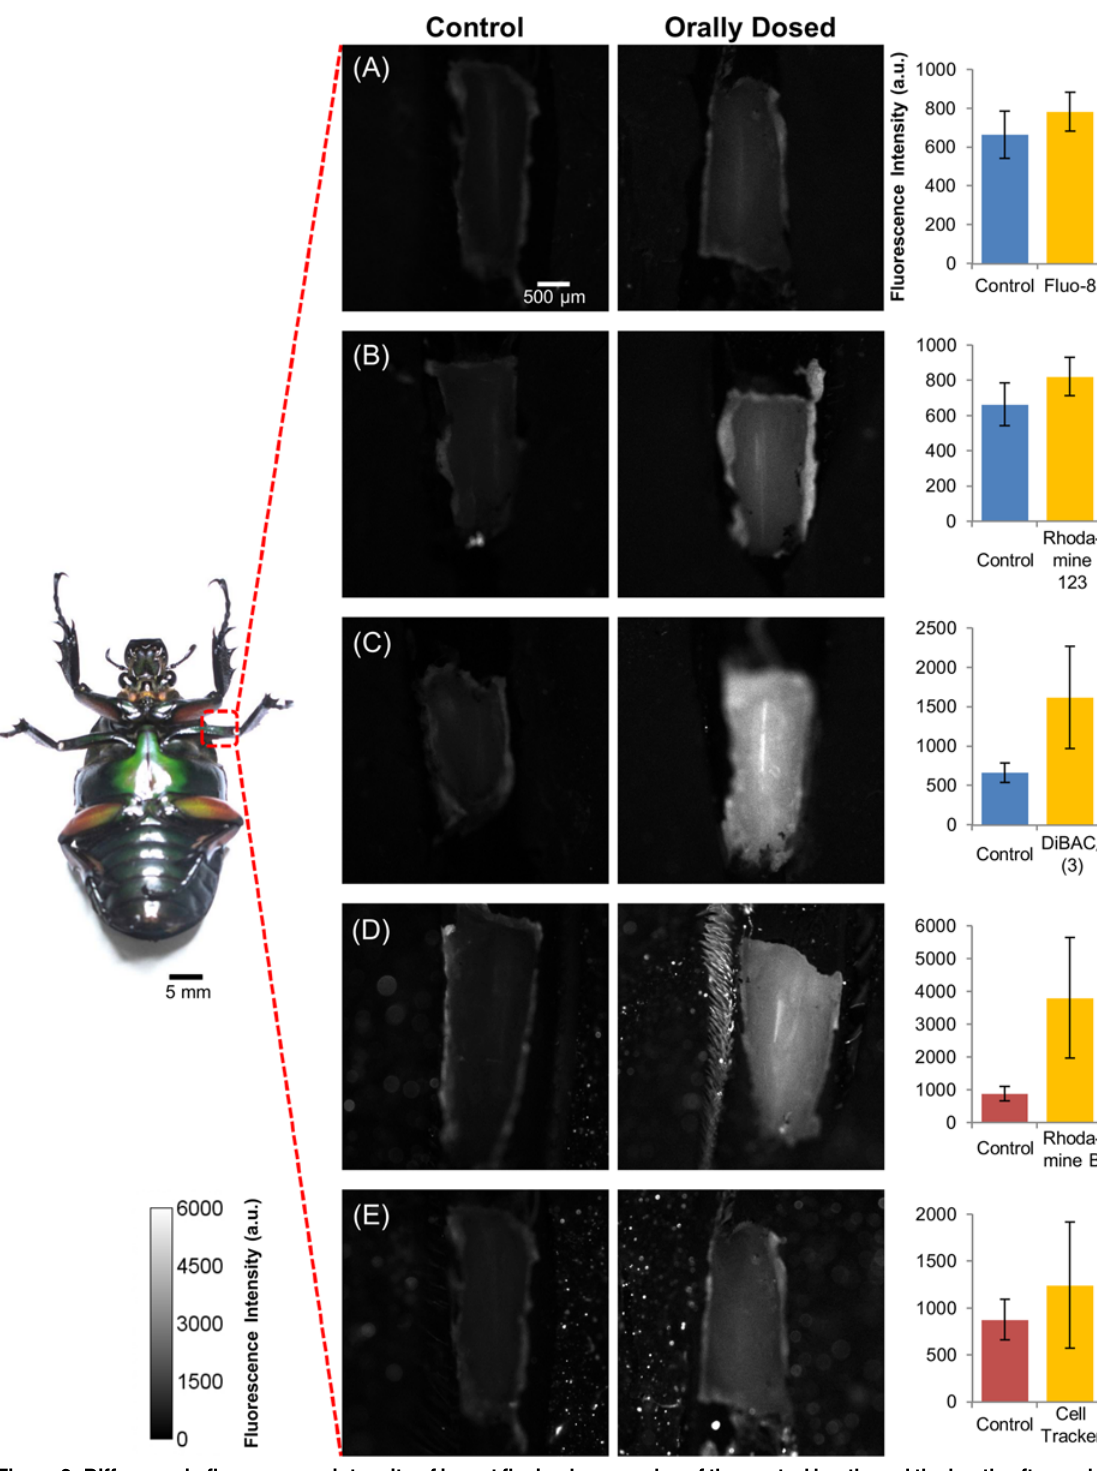
Figure 2. Difference in fluorescence intensity of insect flexion leg muscles of the control beetle and the beetle after oral dosing with chemical indicators. (A) Fluo-8; (B) Rhodamine 123; (C) DiBAC 4 (3); (D) Rhodamine B; and (E) Cell Tracker. The Fluo-8, Rhodamine 123, and DiBAC 4 (3) dosed beetle leg was observed under 460 – 480 nm excitation light and fluorescence emitted was collected within 495 – 540 nm. The Rhodamine B and Cell Tracker dosed beetle leg was observed under 535 – 555 nm excitation light and fluorescence emitted was collected within 570 – 625 nm. Fluorescence intensity was measured at the 2 regions of interest (ROIs) shown in S1A Fig. The images obtained were digitized by ImageJ software, and the averaged intensity is shown